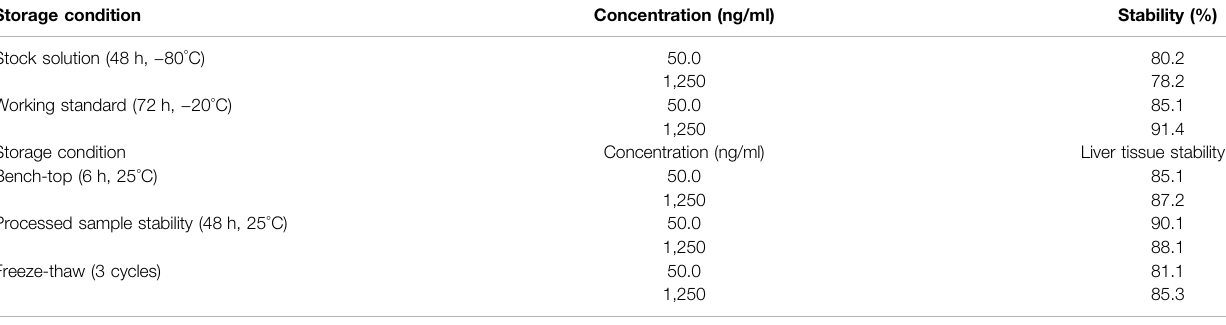
TABLE 3 | Stability of ICG in standard solutions and in murine liver tissue samples. Storage condition